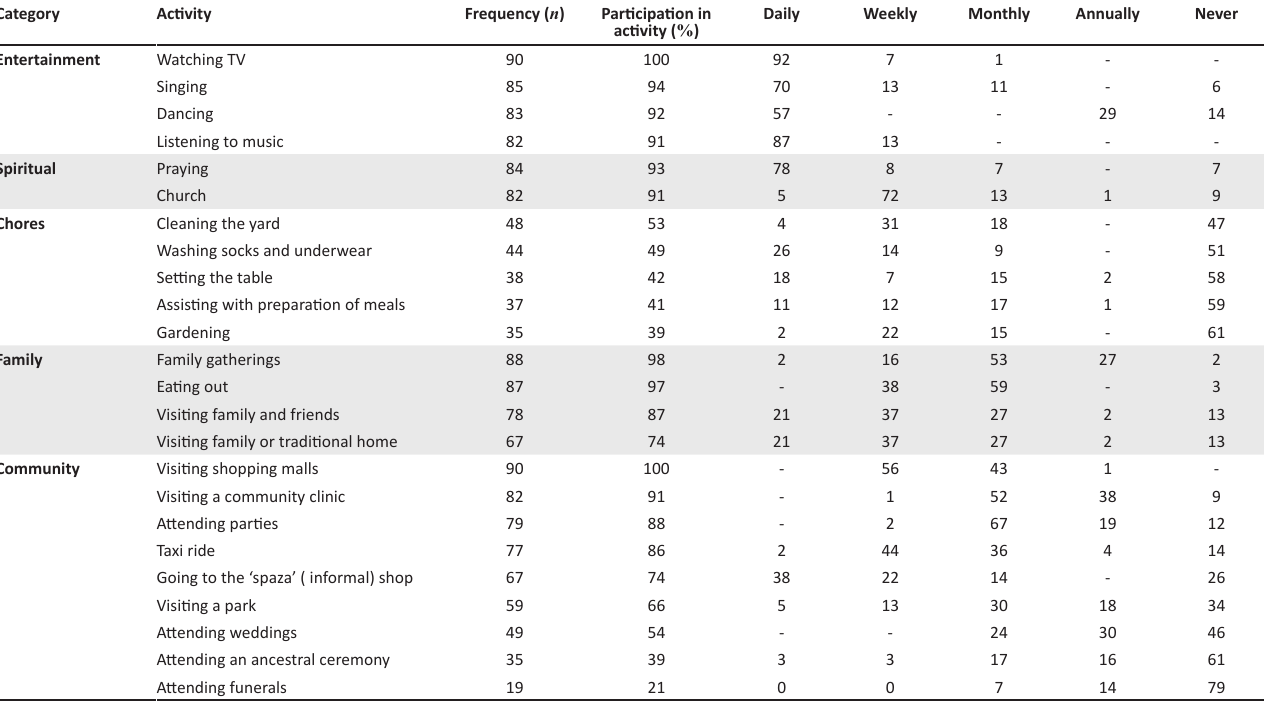
TABLE 1 (Continues...): Frequency of participation ( n =